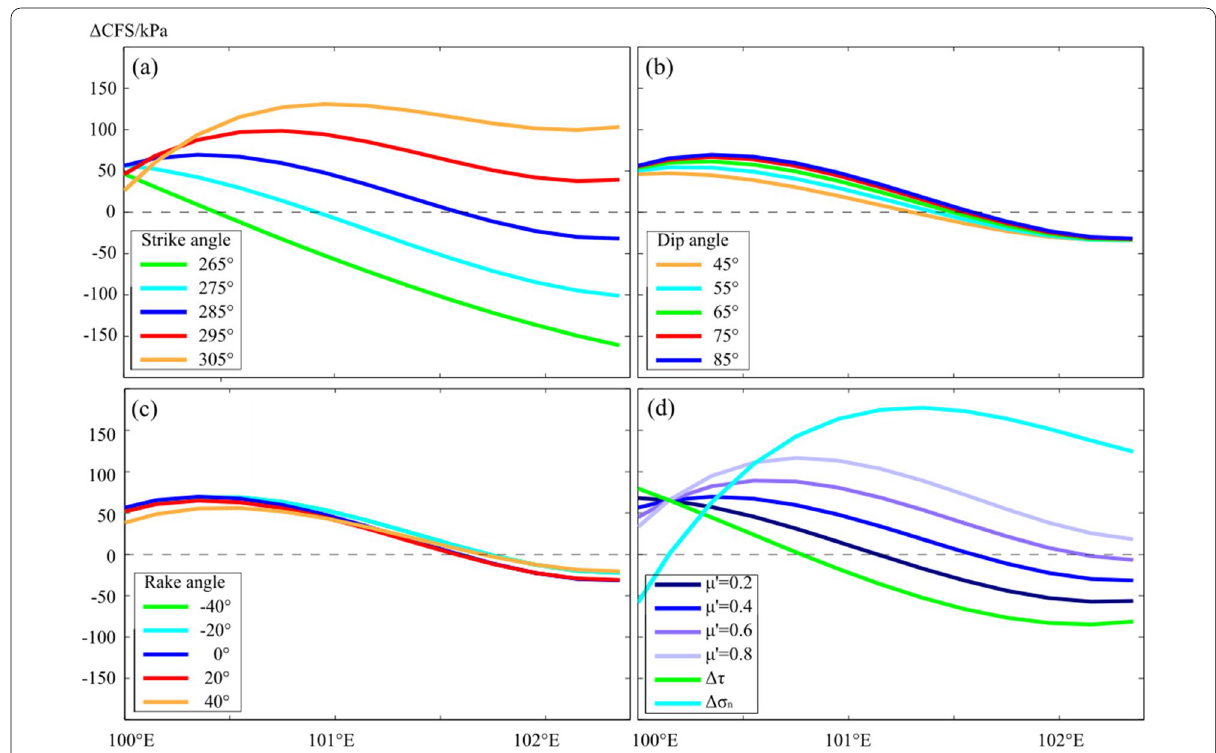
Fig. 11 ΔCFS in the MMS (B1) produced by 14 historical and 2021 Maduo events for various